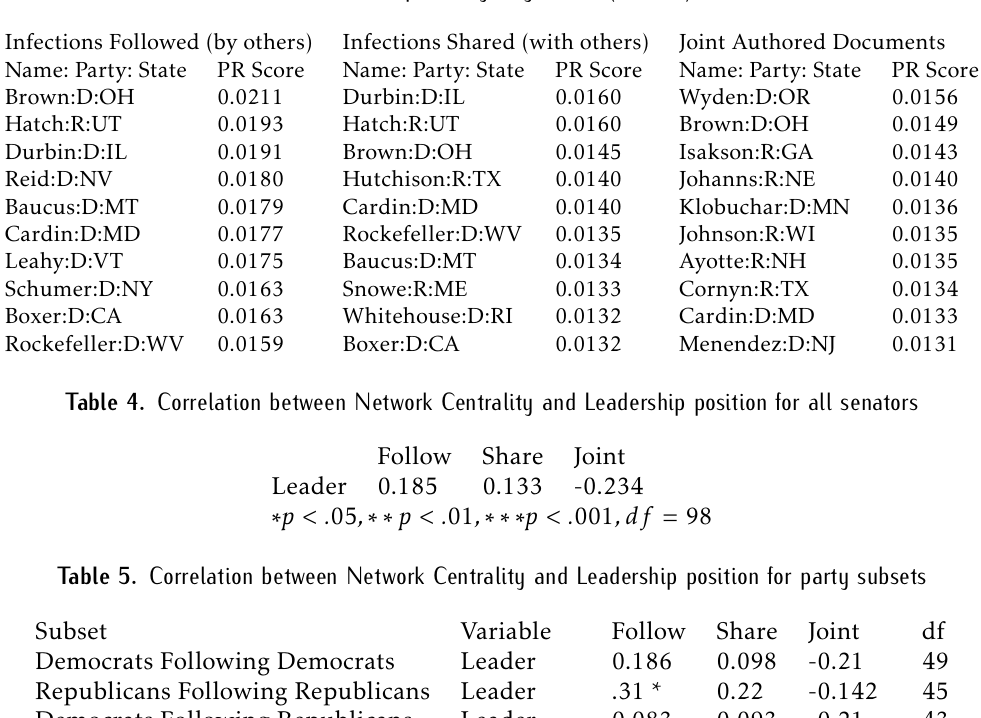
Table 1. Top Ten by Page Rank (infector)